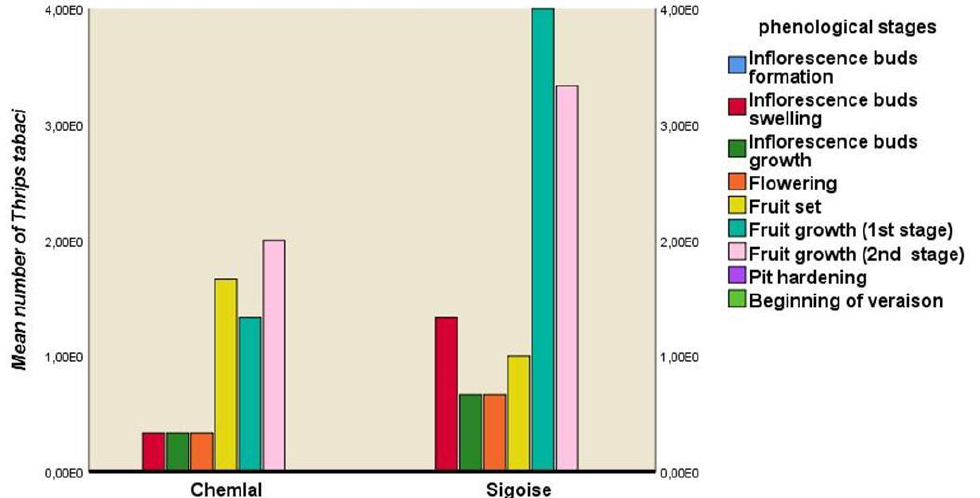
Figure 9. Mean number of T. tabaci according to olive varieties phenological stages in Batna region.